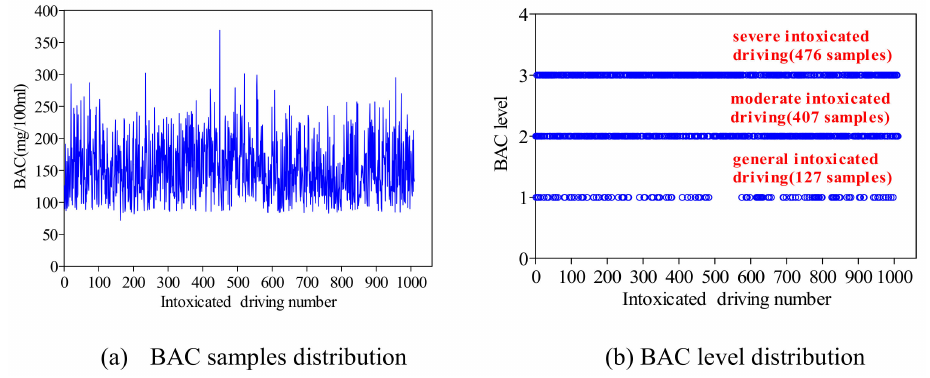
Figure 2. BAC and BAC level distribution among intoxicated